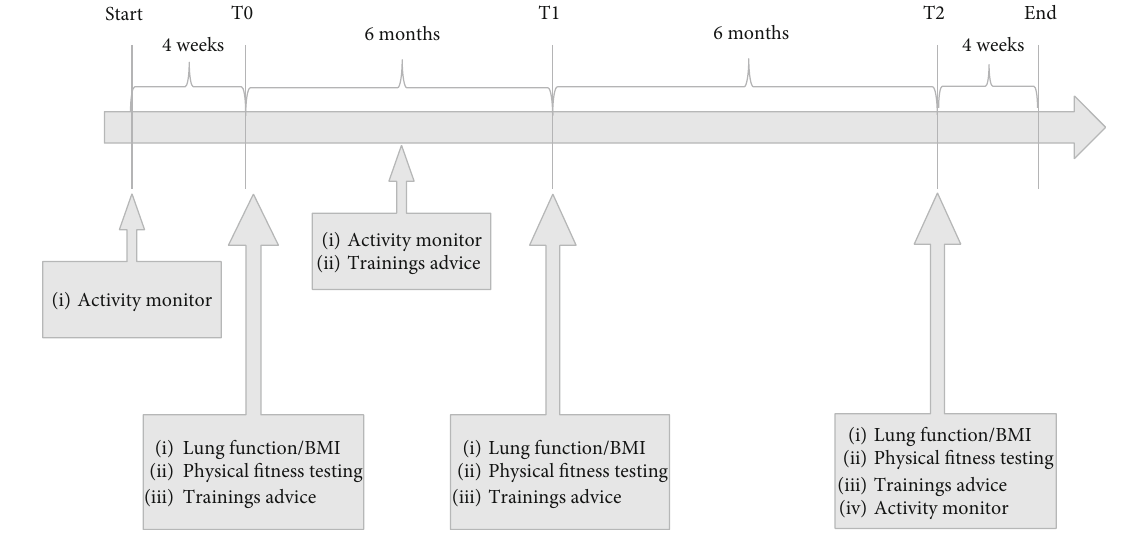
Figure 1: Timeline CFmobil.